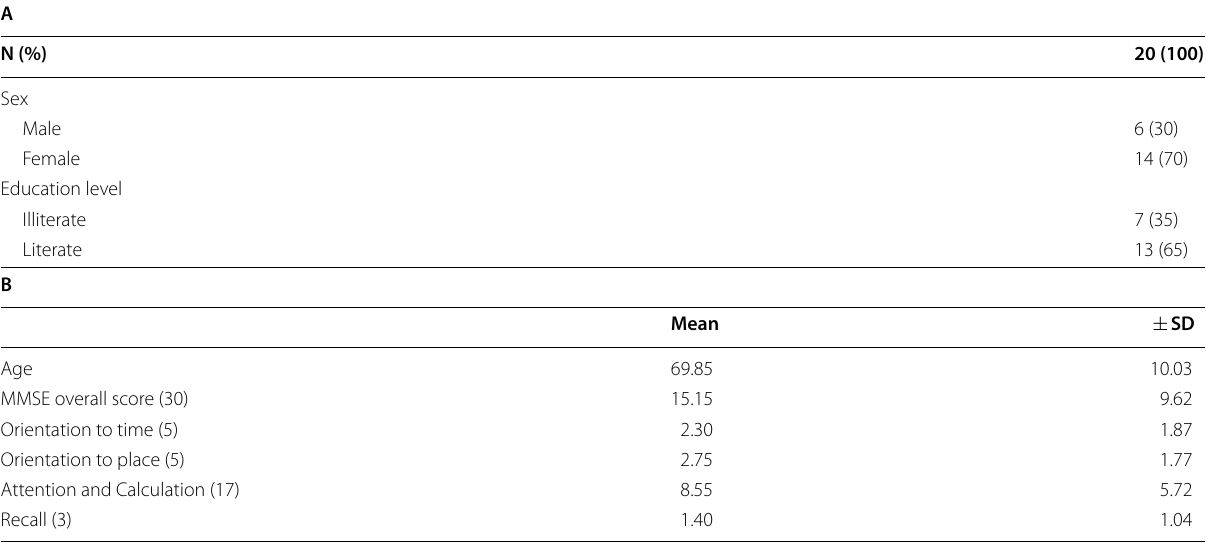
Table 1 Demographic characteristics: (A) Sex and education level, and (B) Mean age and MMSE scores with standard deviation (SD)